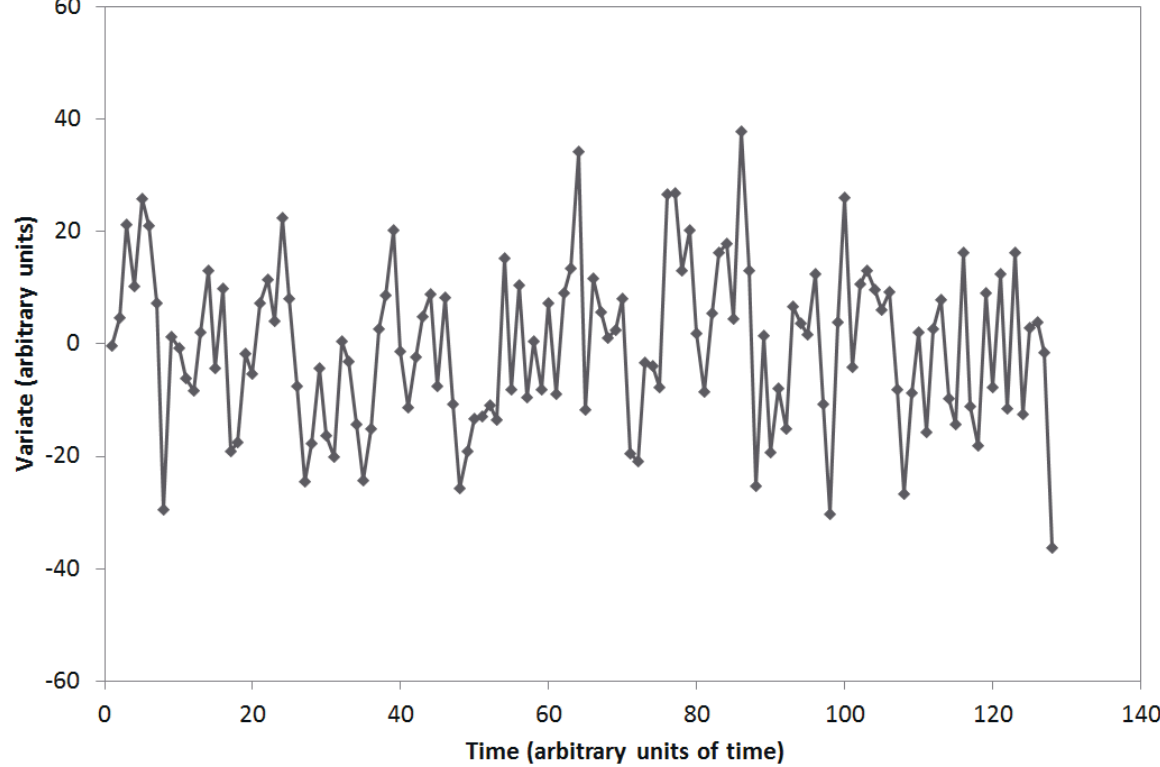
Figure 1. Simulated time series with 128 data and constant sampling interval of one unit.